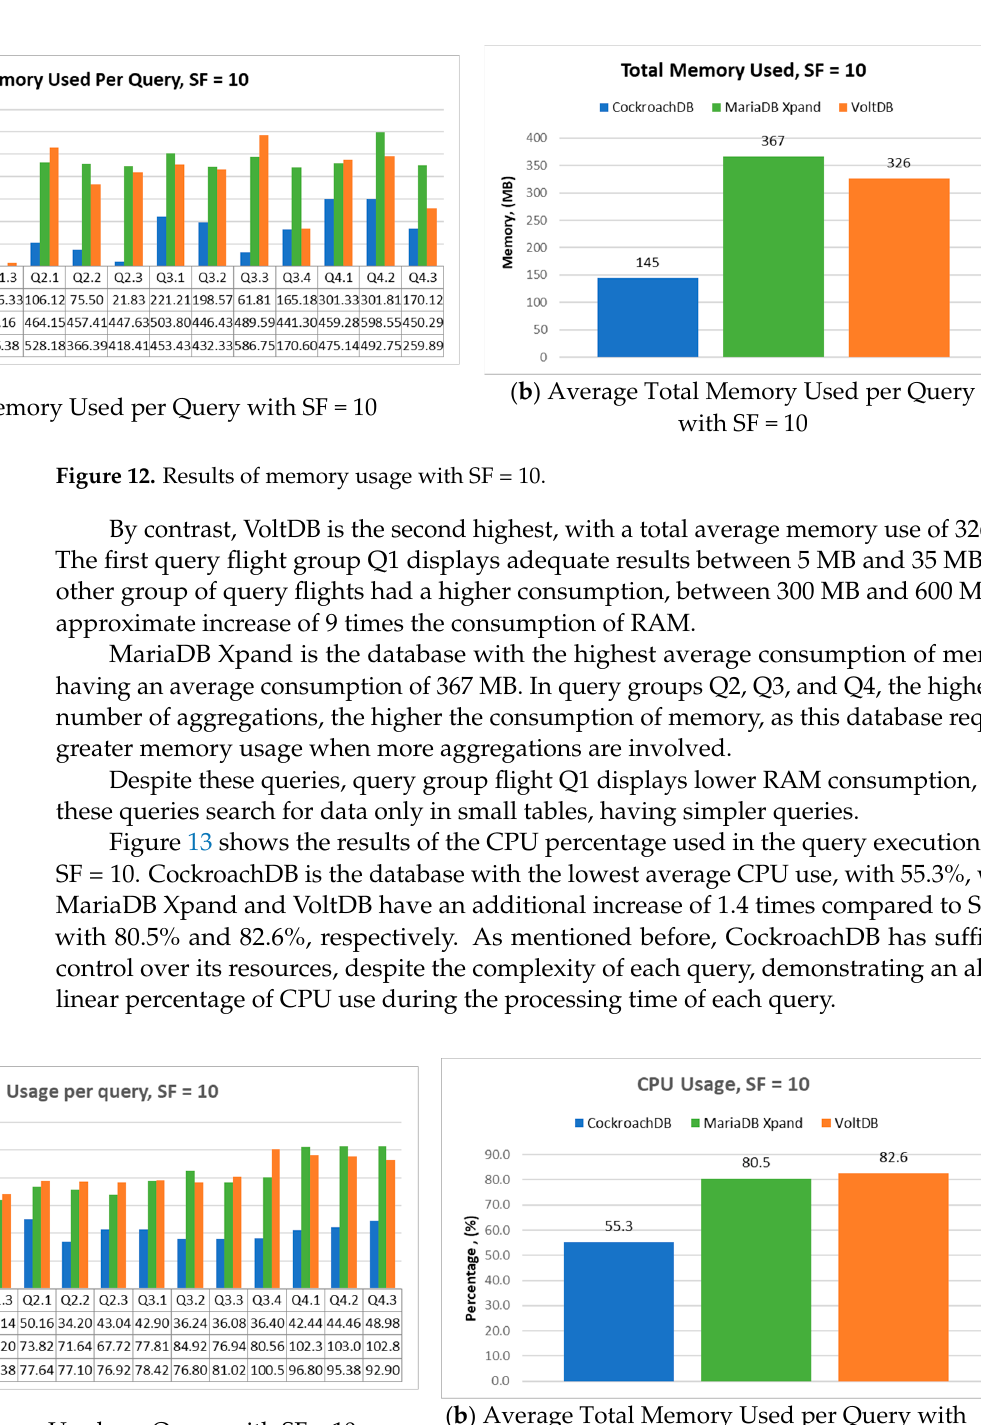
Figure 13. Results of CPU usage with SF = 10.